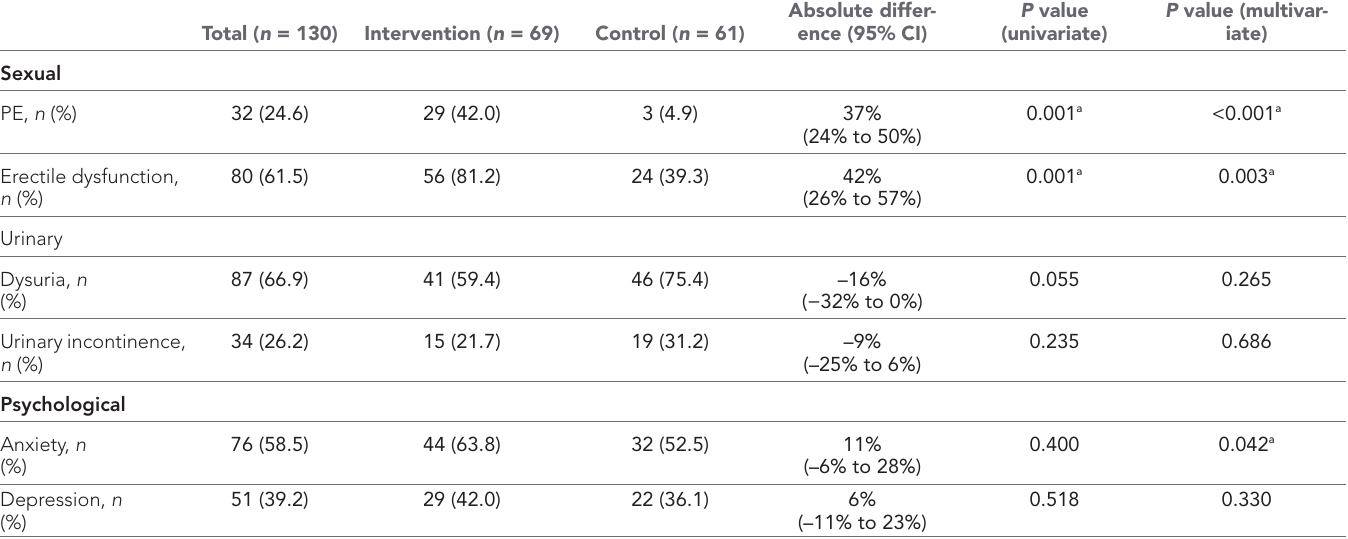
Table 2 Topics discussed during the consultation (outcome questionnaire completed by